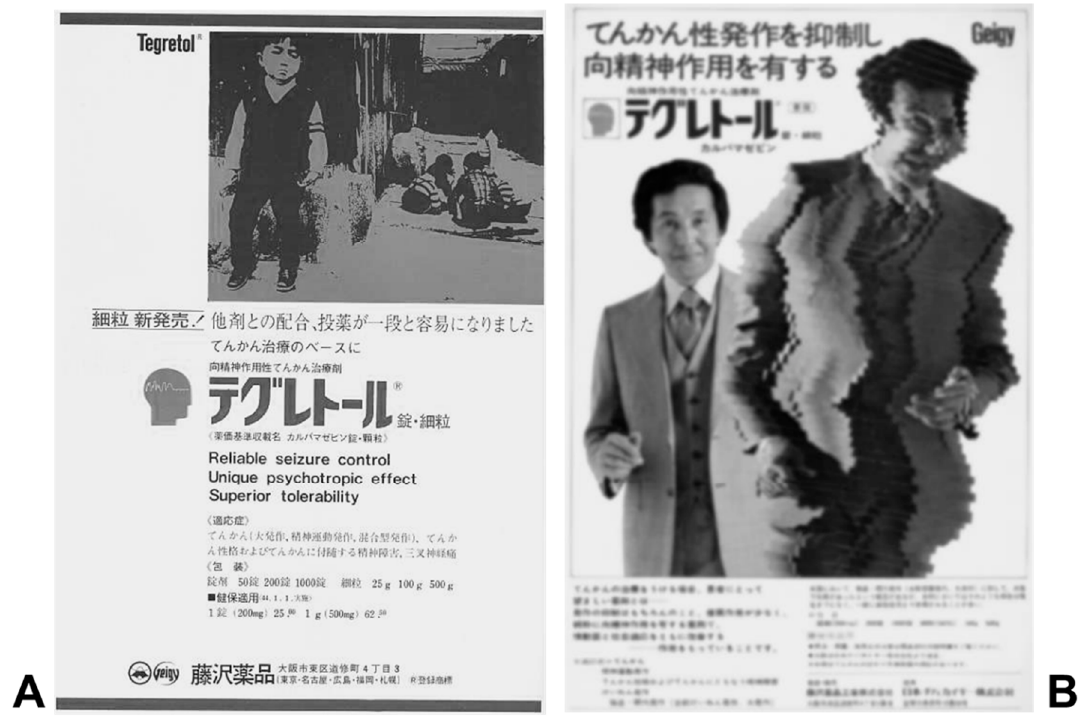
Figure 15. Carbamazepine (Tegretol ® ) advertisements in the Japanese medical press during the 1970s, which emphasized its anticonvulsant and sedative effects. Ads published in the journal Psychiatria et Neurologia Japonica in ( A ) 1970 and ( B ) 1978.